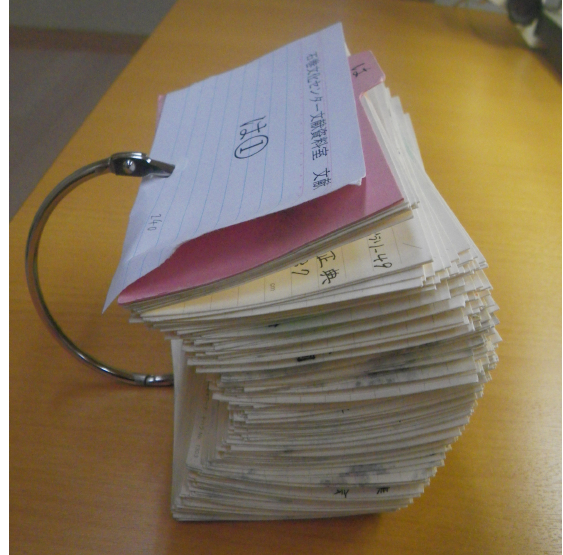
Figure 2: A set of book catalogue